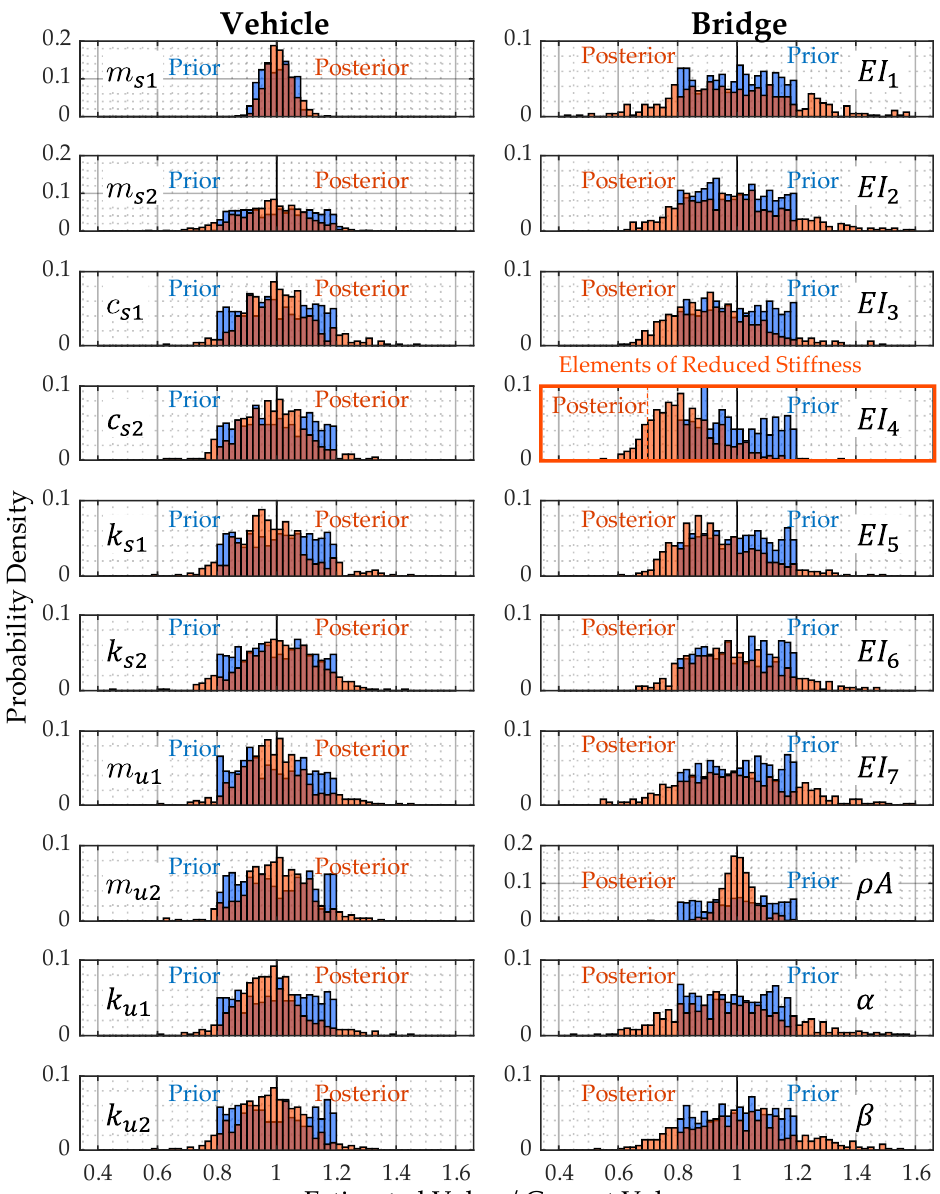
Figure A8. The application results of the PRE method in the case of Scenario 5 (stiffness decrease section: 3𝐿/7 ~ 4𝐿/7 , decrease rate: 30%).